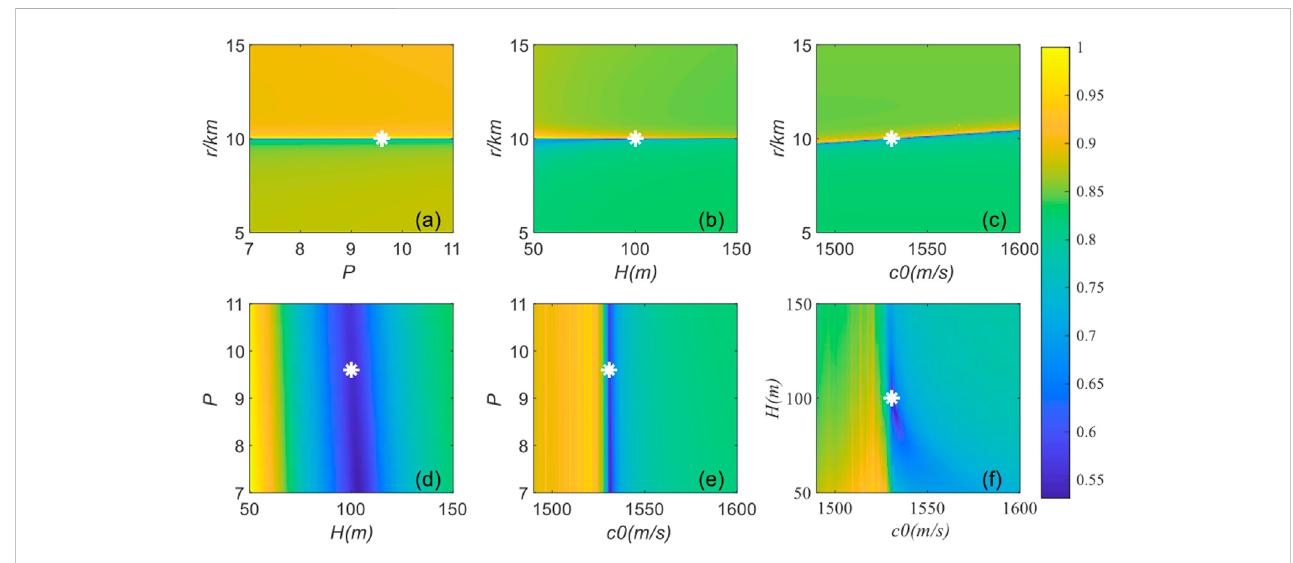
FIGURE 7 Sensitivity analysis results of the two parameters.